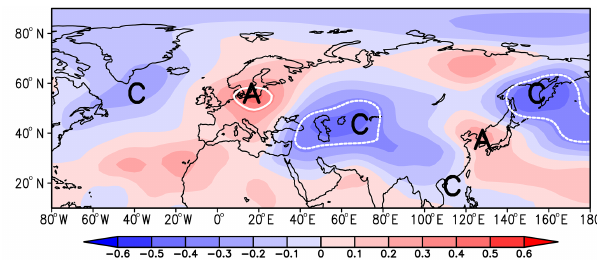
Figure 15. The CC between predictor x 7 ( ×− 1) and Z500 DY in winter from 1980 to 2013. The white curves indicate that the CC exceeded the 95% confidence level.